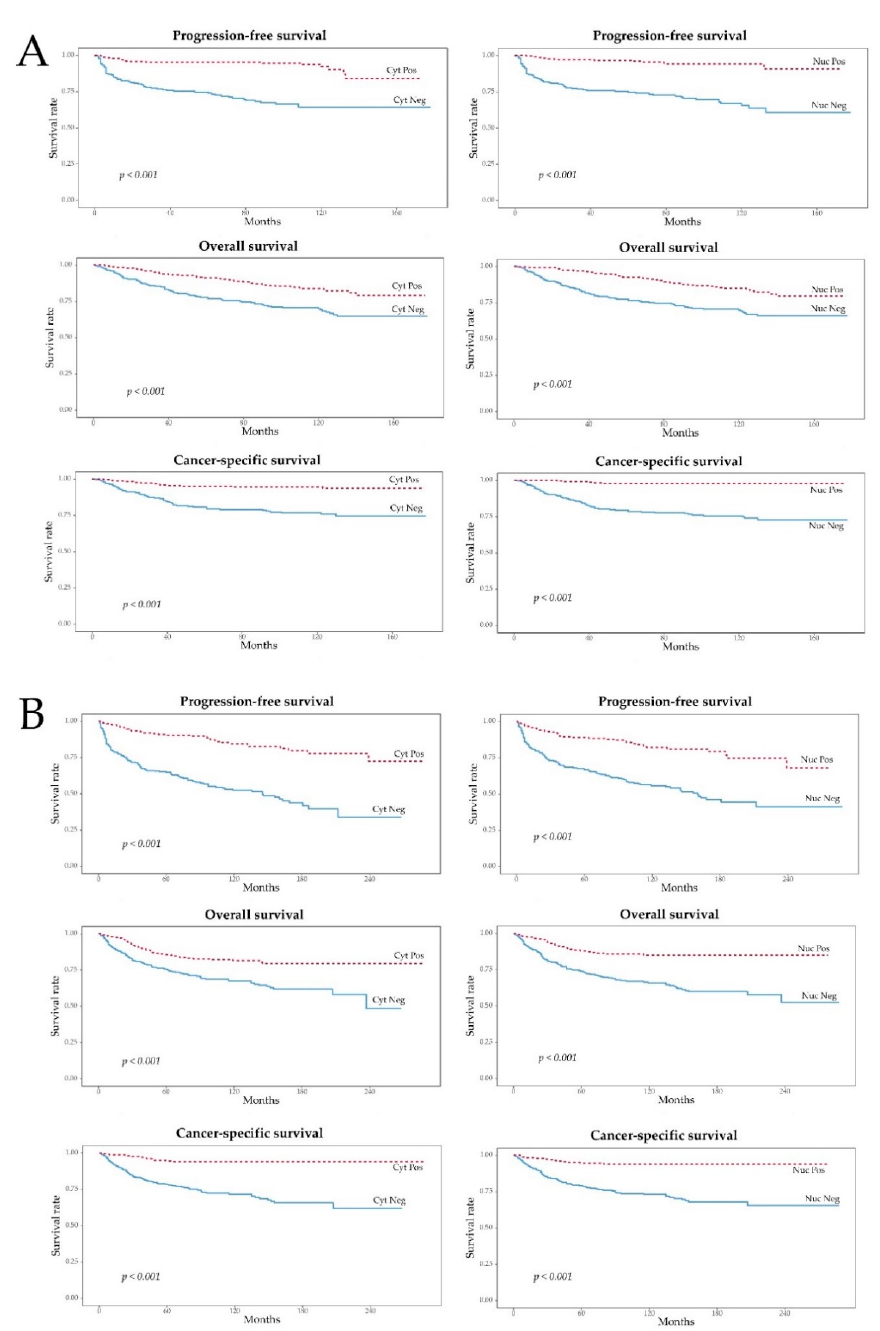
Figure 2. Survival analyses of pAMPK cytoplasmic and nuclear expression. ( A ) Discovery cohort; ( B ) Validation cohort. Cyt, cytoplasm; Pos, positive; Neg, negative; Nuc, nucleus. Table 3. Cox regression analyses for pAMPK expression of the validation cohort.